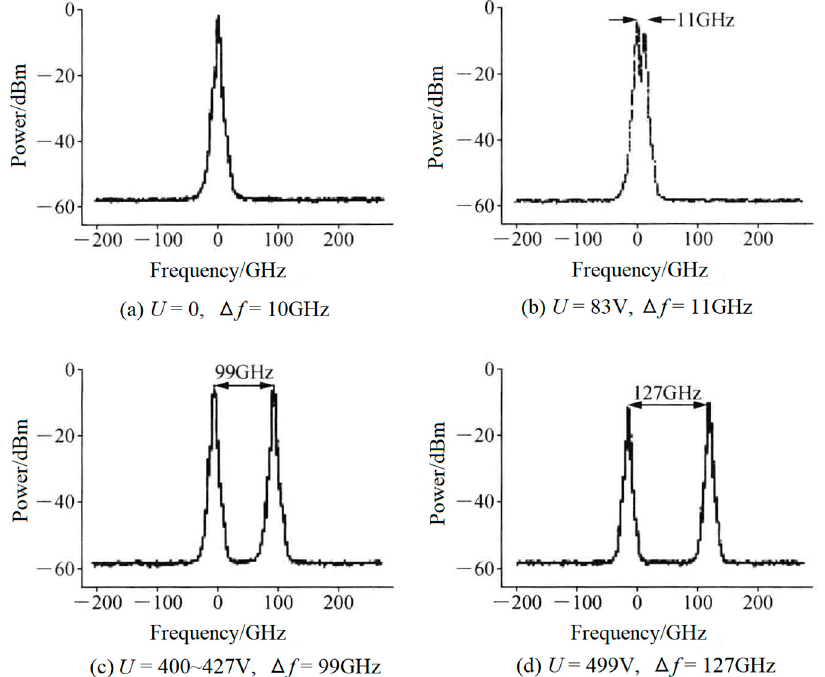
Figure 12. Oscillating spectrum of dual-frequency laser with different frequency difference [25].